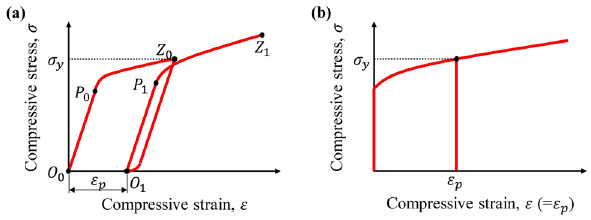
Fig. 3 a Stress–strain curve under compressive load; b Simplified stress–strain